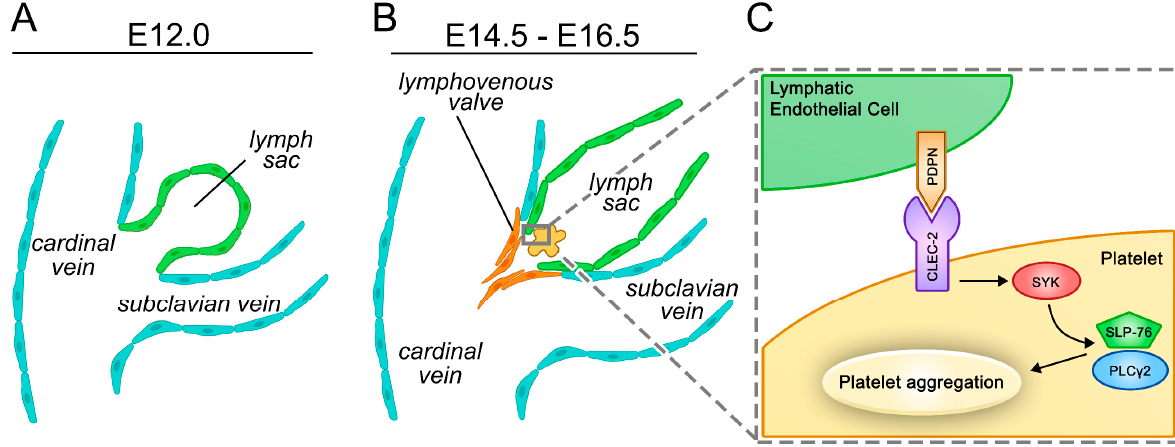
Figure 1. Cellular and molecular mechanisms involved in the separation of the blood and lymphatic vessel systems in mice. ( A , B ) Overview of the separation of the cardinal vein and the lymph sac with the formation of the lymphovenous valve in parallel with the platelet-dependent activation of the C-type lectin-like receptor 2 (CLEC-2)/spleen tyrosine kinase (SYK)/SH2-domain-containing leukocyte protein of 76 kDa (SLP-76)/phospholipase C gamma 2 (PLC γ 2) pathway. ( C ) The CLEC-2/SYK/SLP-76/PLC γ 2 pathway in platelets recognizing podoplanin (PDPN) expressed on the surface of lymphatic endothelial cells (LECs) is critical for the proper separation of the two circulatory systems.